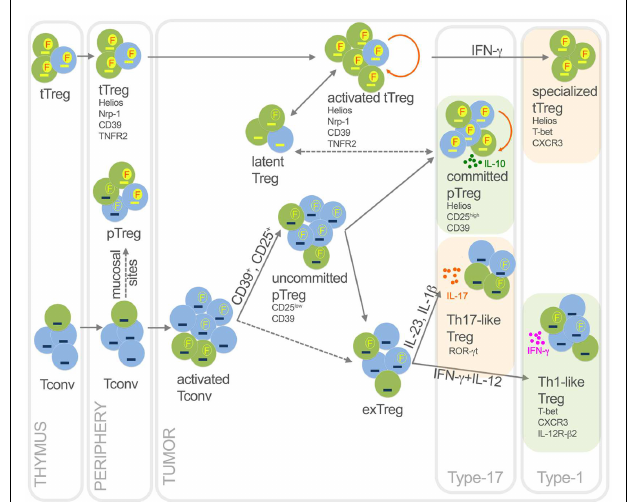
FIGURE 2 | Functional dynamics of tT reg and pT reg in cancer .This picture summarizes development, heterogeneity, plasticity, antigen specificity, and function of pT reg and tT reg in cancer. ActivatedT reg , which are epigenetically committed and mostly self- andTAA-specific, can transiently lose Foxp3 without methylatingTSDR thus becoming latentT reg ; in some conditions, they can acquireT-bet expression thus becoming specialized suppressors, detrimental to the anti-tumor type-1 response. ActivatedT conv , mostly foreign (TSA) antigen-specific, can promiscuously express Foxp3 without demethylatingTSDR. However, a fraction (CD25 + , or CD39 + ) of activated T conv can convert into pT reg , progressively moving from an uncommitted to a committed stage.Through IL-10, committed pT reg can suppress pro-tumoral inflammatory and type-17 responses, thus exerting beneficial roles for the host in some cancer types. In some contexts, uncommitted pT reg (and possibly activatedT conv ) can move back to exT reg stage, acquiring the ability to produce inflammatory cytokines.Therefore, in some tumors such as colon cancer,Th17-likeT reg may foster type-17 inflammation thus supporting tumor growth; in other tumor contexts,Th1-likeT reg can favor type-1 responses that rather block tumor growth. Green, cells specific for self-antigens andTAA; light blue, cells specific for foreign antigens including TSA.Yellow dash, demethylatedTSDR; blue dash, methylatedTSDR. Red “F” in yellow circles, stable Foxp3; yellow “F” in empty circles, unstable Foxp3. Dashed arrows, unclear events. Orange rounded arrows, proliferation in the tT reg or the pT reg homeostatic niche. Light green frames, conditions in whichT reg are beneficial to the host; light orange frames, conditions in whichT reg are detrimental to the host.